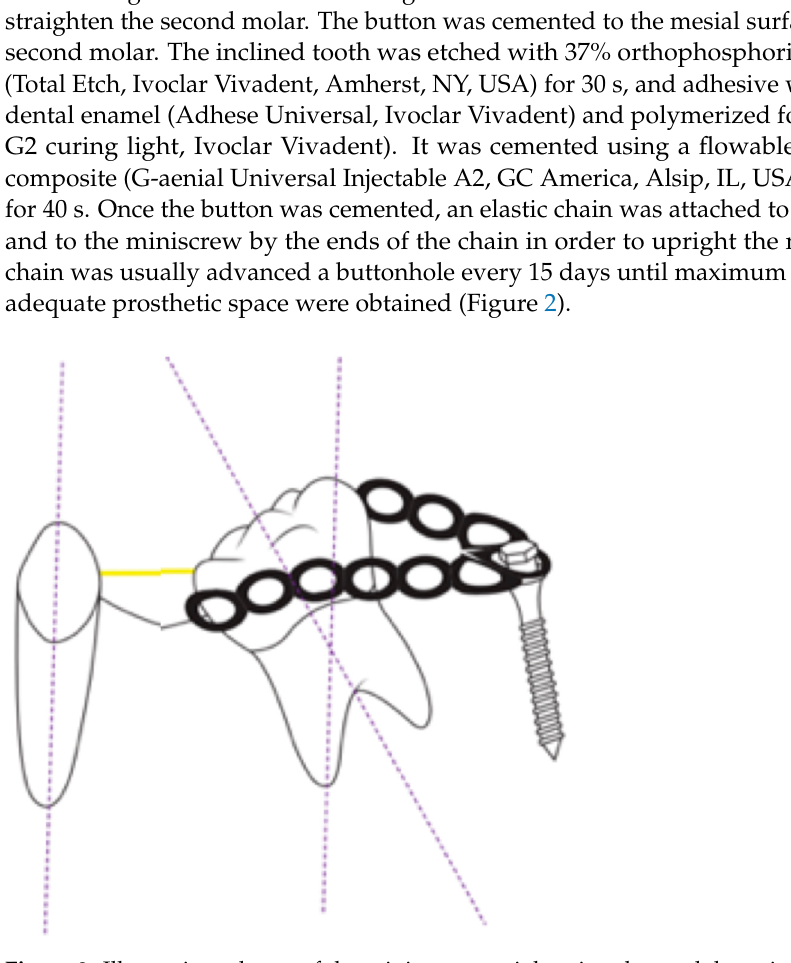
Figure 2. Illustrative scheme of the miniscrew straightening the tooth by using the mesial button attached to two elastic chains.